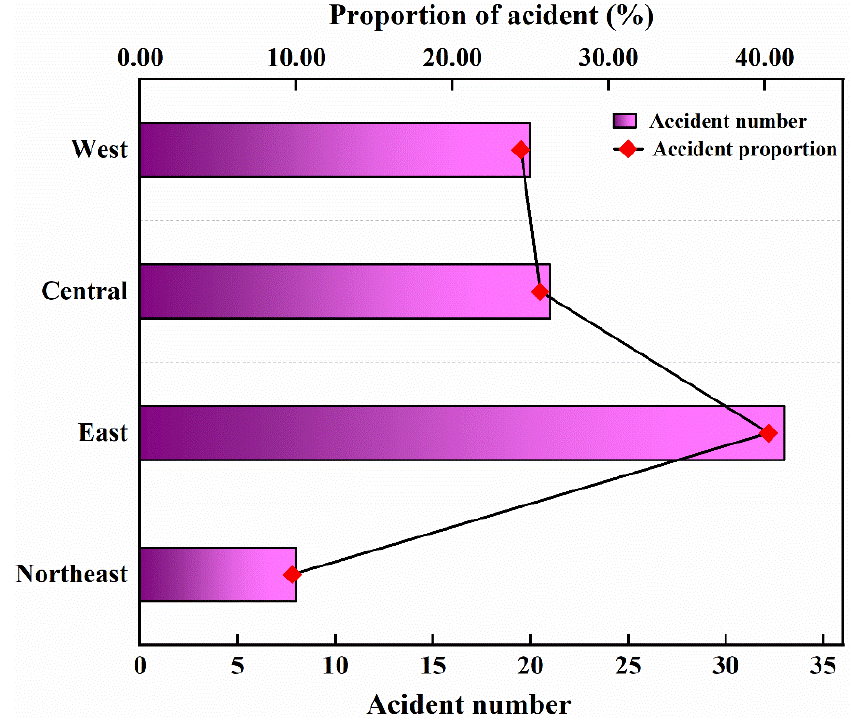
Figure 7. Accident number and proportion by four economic zones.